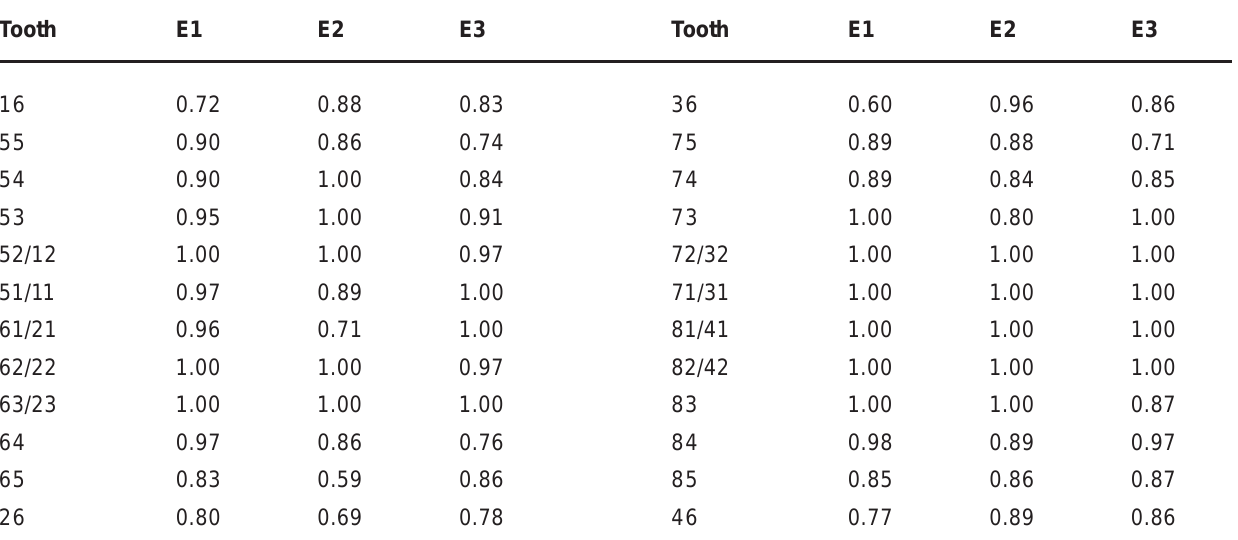
E1=Exercise at baseline; E2= Exercise after 3 months; E3= Exercise after 6